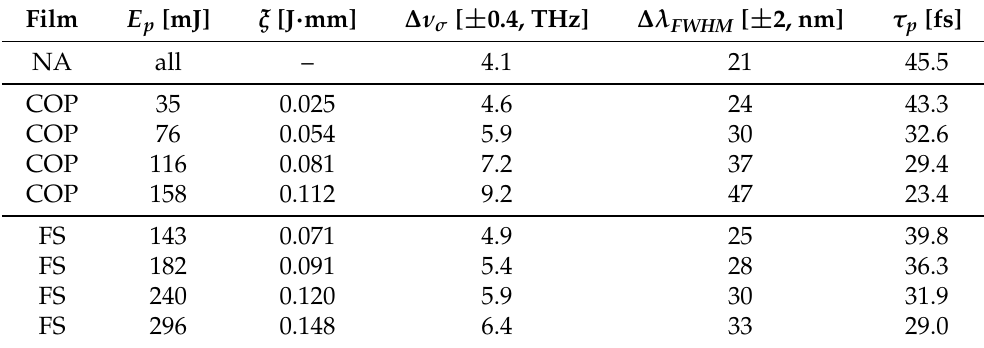
Figure 3. The measured spectra and phase response of the pulse passing through six layers of COP film are shown in ( a ). The pulse energy increases from top left to bottom right, corresponding to 35 mJ, 76 mJ, 116 mJ and 158 mJ, respectively. Superimposed in gray are the original spectra measured with no material present. In ( b ), the spectra and phase measured using a fused silica (FS) plate are shown. The measured response of the COP film is compared with FS in ( c ). The induced bandwidth ( δω rel ) relative to the original reference bandwidth ∆ ω o of the input pulse is shown vs. the parameter ξ . A linear regression performed on the two data-sets is superimposed on the measurements (solid line), as well as the results obtained from simulations (dashed lines). Table 1. Measured pulse parameters for reference pulse with no film installed (NA), 6 × COP with total effective thickness of 0.69 mm, and fused silica (FS)